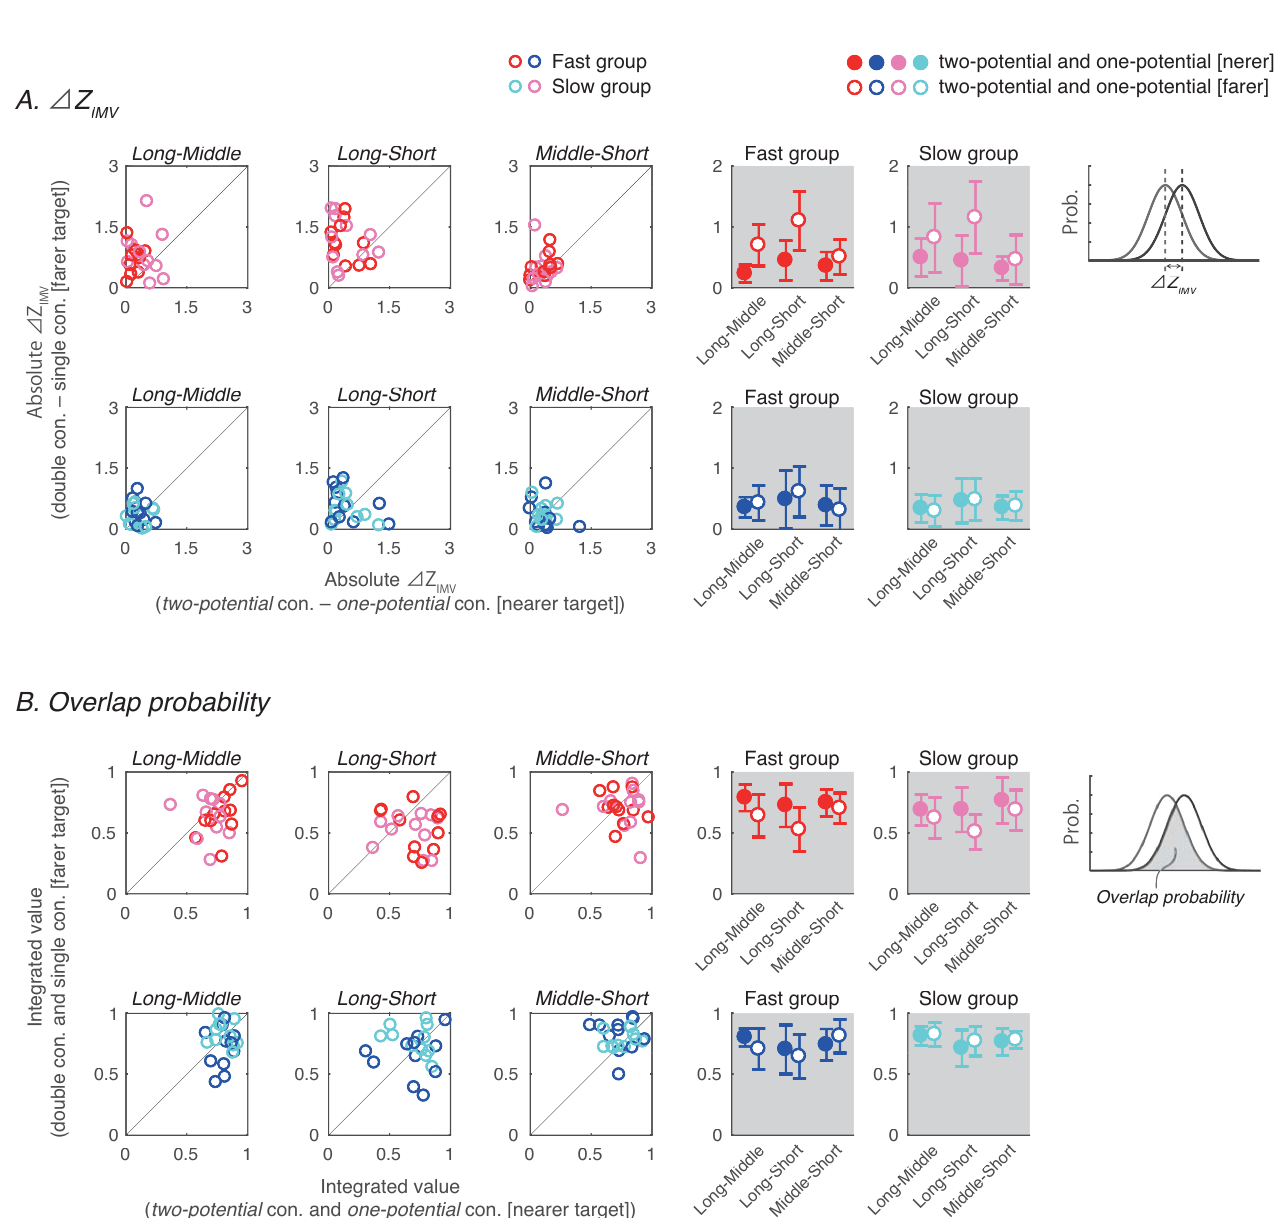
Fig 5. Similarity of the initial movement velocity between the two-cursor/target condition and the corresponding one-cursor/target condition. (A) Left three panels show the comparisons between Δ Z two − one [ nearer ] and Δ Z two − one [ farer ] in each participant were shown in each distance condition. Right two panels and Δ Z . (B) Comparison between the overlap probability of show the comparisons between inter-participant means of Δ Z two − one [ nearer ] two − one [ farer ] distributions of the two-cursor/target conditions and the nearer one-cursor/target conditions and the overlap probability of distributions of the two-cursor/target conditions and the farer one-cursor/target conditions. Since the smaller/larger the value of Δ Z two − one /overlap probability, the higher the similarity, it was found that the initial movement velocity in the two-target condition was more similar to the one-target condition to the near target. On the other hand, there was no difference in the similarity of the initial movement velocity between the two-cursor and near one-cursor condition, or between the two-cursor condition and far one-cursor